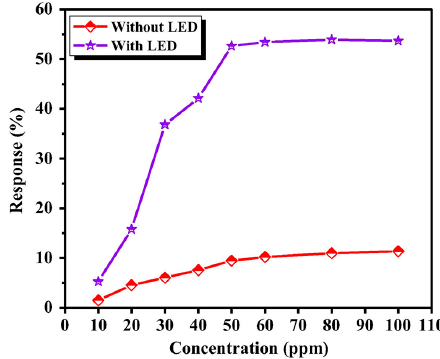
Figure 5. Response of ZnO with and without LED irradiation towards different concentration levels of hydrogen peroxide. Reproduced with permission from [42].